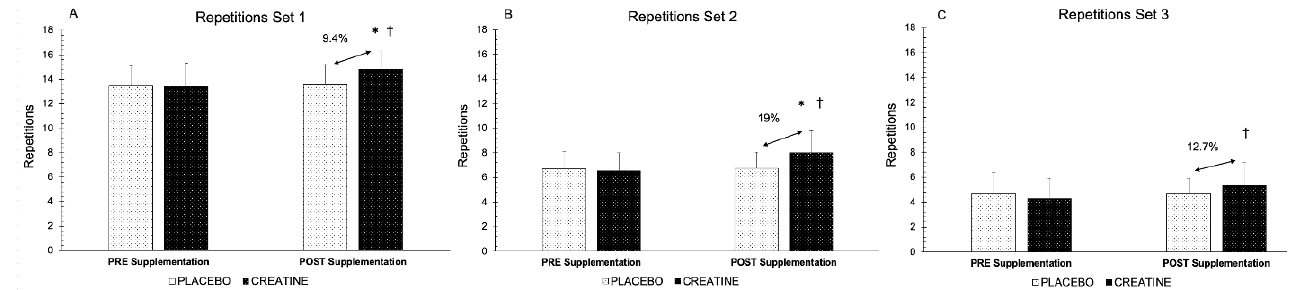
Figure 3. ( A ) Repetitions performed in Set 1 of the protocol of 3 × MNR 70% of MPV in the 1RM test pre- and post-supplementation. ( B ) Repetitions performed in Set 2 of the protocol of 3 × MNR 70% of MPV in the 1RM test in pre- and post-supplementation periods. ( C ) Repetitions performed in Set 3 of the protocol of 3 × MNR 70% of MPV in the 1RM test in pre- and post-supplementation periods. † = significant difference between pre- and post-supplementation periods ( p < 0.05). MNR = Maximum Number of Repetitions; MPV = Mean Propulsive Velocity. * = significant difference between groups ( p <